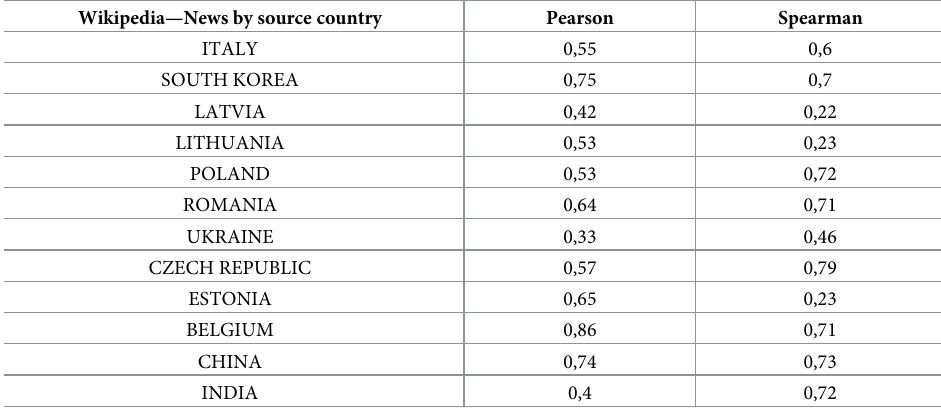
Table 1. Pearson and Spearman correlation between Wikipedia pageviews and news volume. Wikipedia—News by source country